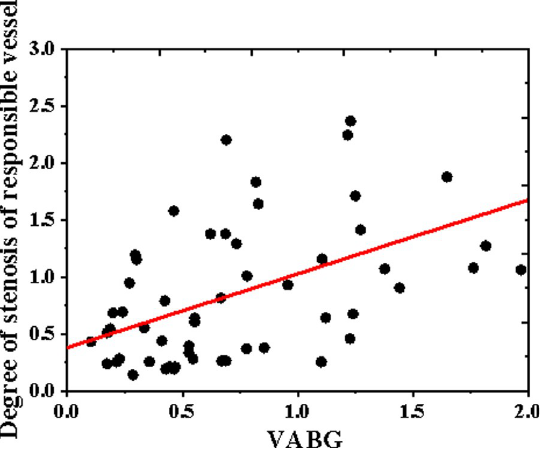
Fig 7. Correlation between VABG and degree of stenosis of the responsible vessel.